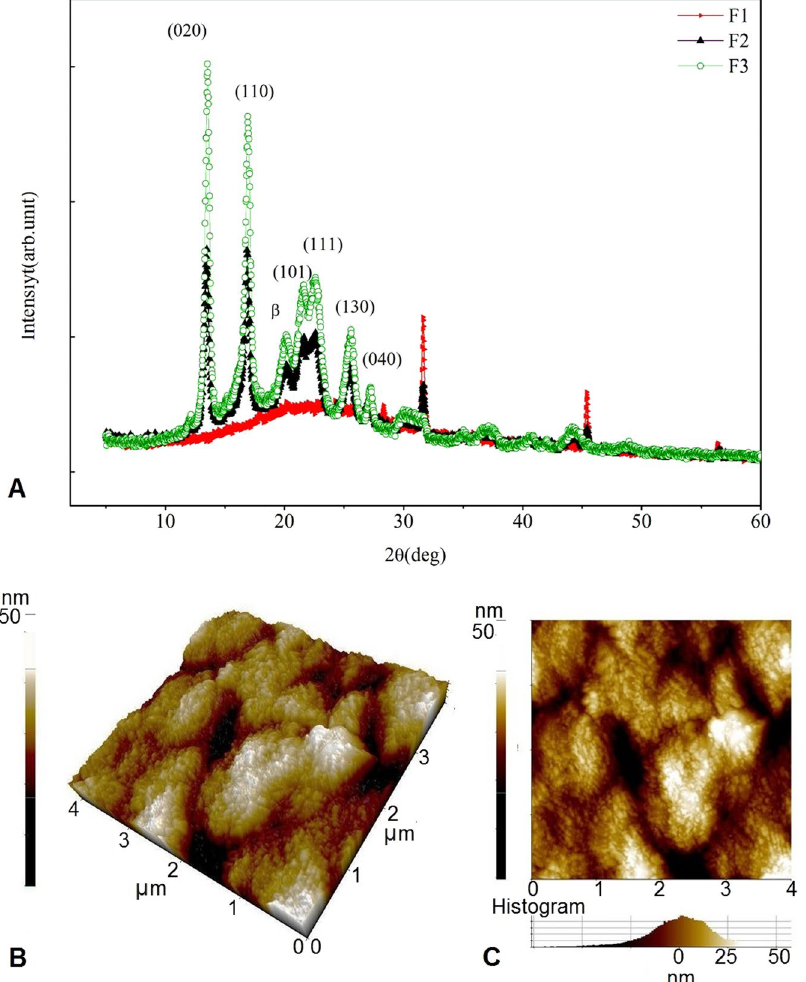
Figure 6. ( A ) X-ray diffractograms of the film. The peaks represented in green (F1) are for the film prepared using increased concentration of PHB, Nm and glycerol blend (2:1:1) with high intensity peaks, indicating the crystallinity of the film. Peaks shown in black (F2) correspond to the film prepared using equal proportion of the components Nm: PHB: glycerol (1:1:1) and displayed a similar diffraction pattern as the peak obtained with the increased concentration of PHB. Peaks represented in red (F3) are the film prepared using increased melanin: PHB: glycerol (2:1:1) which displayed a broader peak in the diffraction pattern of 20.2° to 26.8°. ( B , C ) Figure shows the AFM images of the samples scanned in an area of 4 μ m 2 . AFM topographical images of melanin nanocomposite film prepared with equal proportion of PHB, Nm and glycerol blend (1:1:1). The topographical scale of the images in 3D ( B ) and 2D ( C ) are shown in 50 nm scales. The roughness of the film was found to be 12.4